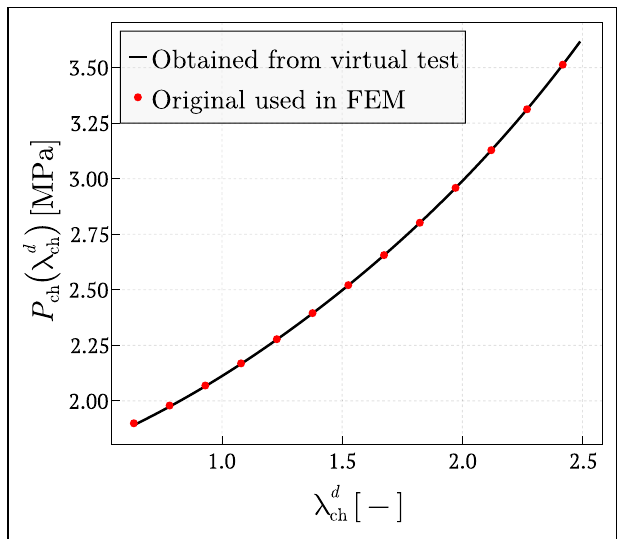
FIGURE 5 | Plot comparing P ch ( λ d ch ) extracted from (Amores et al., 2020, Figure B.1) and the reverse-engineered P ch ( λ d ch ) obtained with the methodology described in the article.